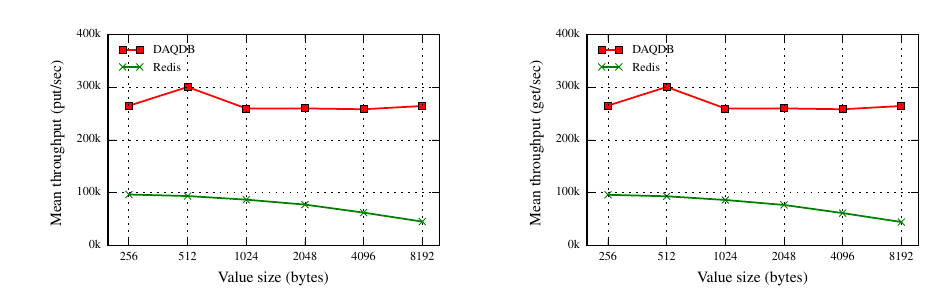
Figure 6. Operations per second of a single filter- ing thread using DAQDB and Redis for di ff erent value